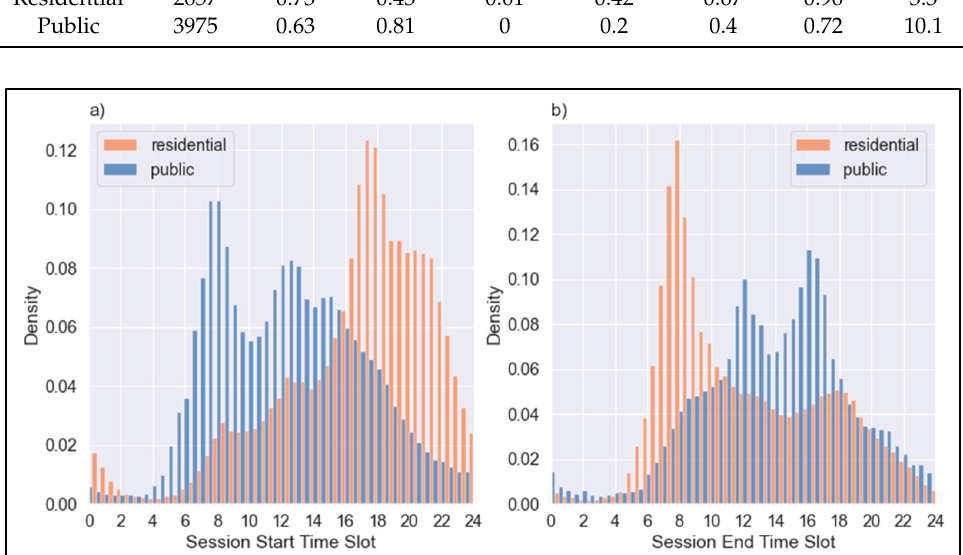
Figure 2. Distribution of public and residential charging event counts over ( a ) session starts and ( b ) session ends.